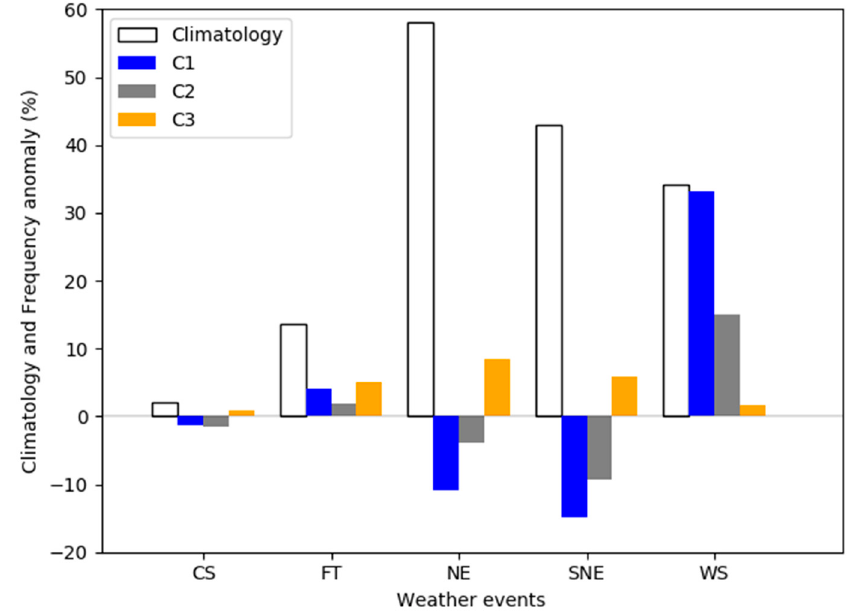
Figure 4. Climatological frequencies of the synoptic weather events (white bars) and the frequency anomaly of the weather events in C1–C3 (colored bars) from October to March in 2006–2015 based on Taiwan Atmospheric event Database. Here, the frequency anomaly of the weather events is defined as the difference between the climatological frequency of the weather events and the frequency that a certain cluster occurred concurrently with the weather events.